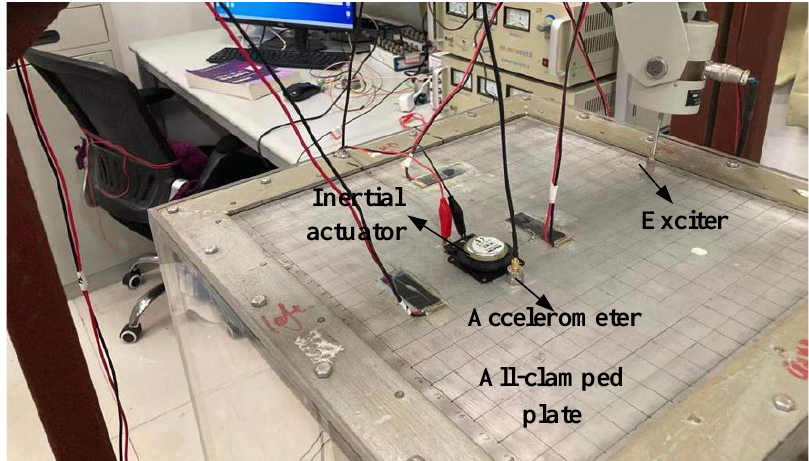
Figure 4. The experimental platform of vibration control. Table 1. Inertial actuator parameter.